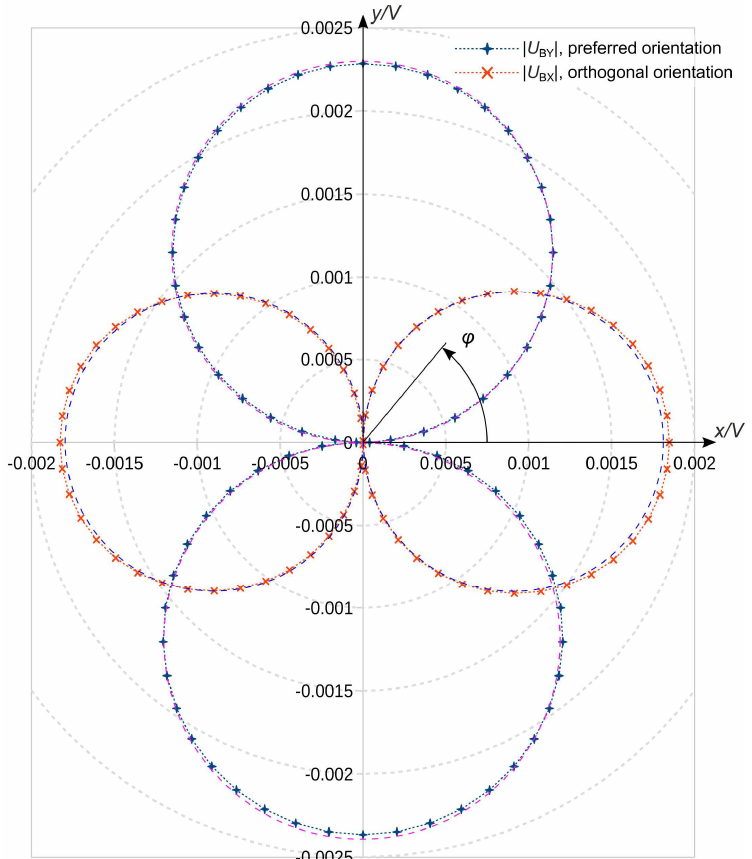
Figure 2. Simulated polar plots of the magnitude of two bridge unbalance signals versus flow azimuth angle for the design of Figure 1a. The tilt azimuth 𝜑 was manually incremented from 0° to 360° in uniform steps of 5°, the bridge supply voltage amounts to 1 V, the heating power to 2.5 mW and the NTC to 0.02 K −1 . Dashed circles indicate the ideal |sin(𝜑)| and |cos(𝜑)| characteristics.